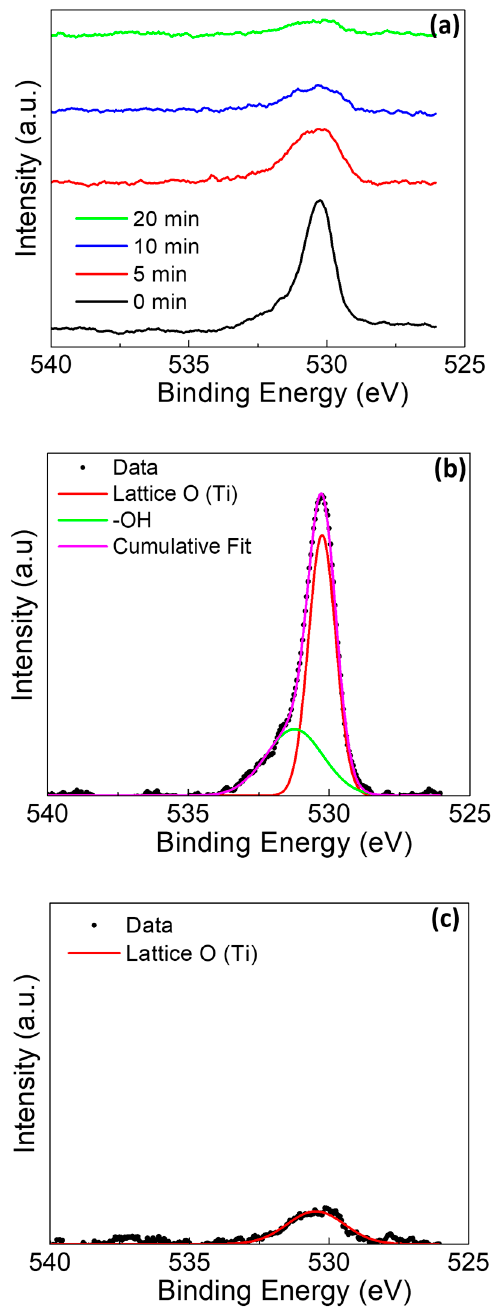
Figure 7. O1s XPS of Ti rod without amalgam at pH 2 ( a ) at various sputter times, ( b ) at deconvolution of 0 min sputter time, and ( c ) at deconvolution of 20 min sputter time.